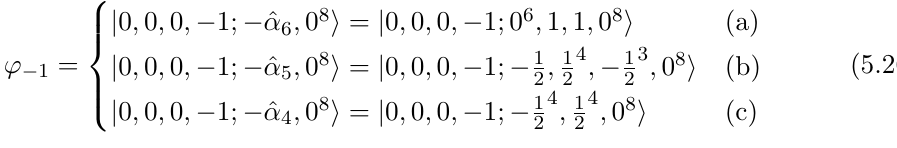
Figure 8. Extended diagram for Wilson lines A 1 = 1 Curiously it corresponds to the product of what are referred to as over-extended diagrams for E 7 , in this case written as E ++